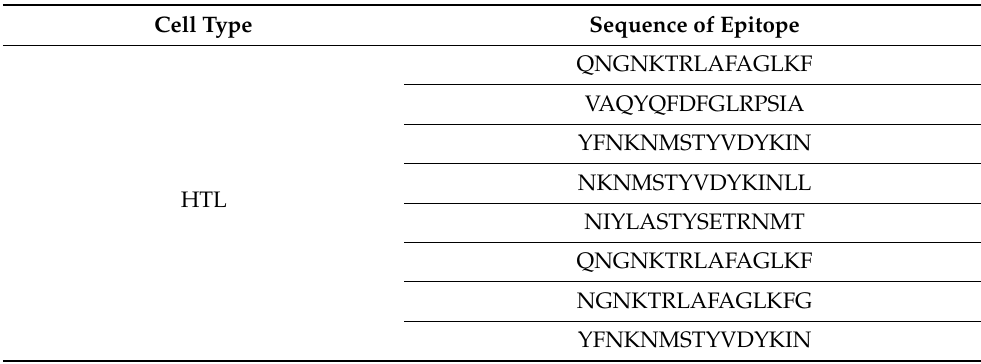
Table 2. List of epitope candidates for vaccine